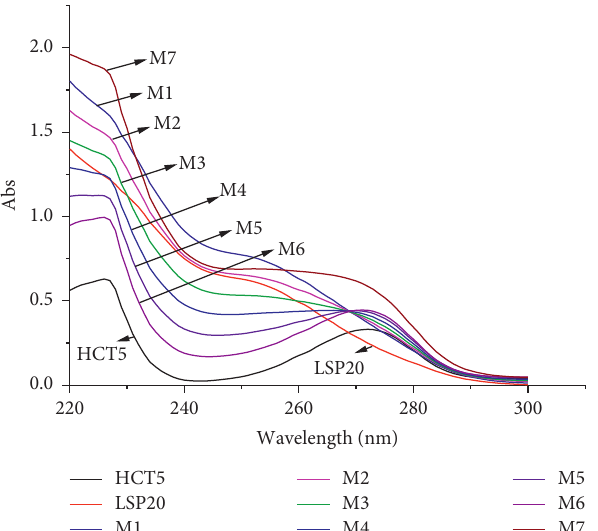
Figure 1: Absorption spectra of the HCT and LSP standards and their mixtures at different concentration ratios. HCT5: HCT standard solution of 5.000 μ g/mL; LSP20: LSP standard solution of 20.000 μ g/mL; M1: mixture of HCT 1.000 μ g/mL+LSP 24.000 μ g/mL; M2: mixture of HCT 2.000 μ g/mL +LSP 20.000 μ g/mL; M3: mixture of HCT 3.000 μ g/mL+LSP 16.000 μ g/mL; M4: mixture of HCT 4.000 μ g/